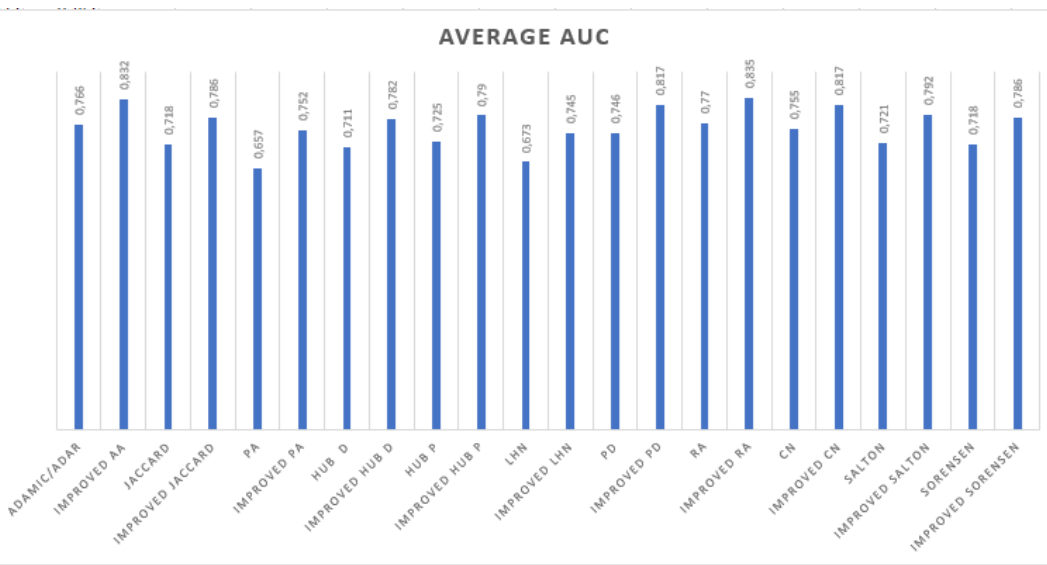
Figure 2. Average AUC of the algorithms.